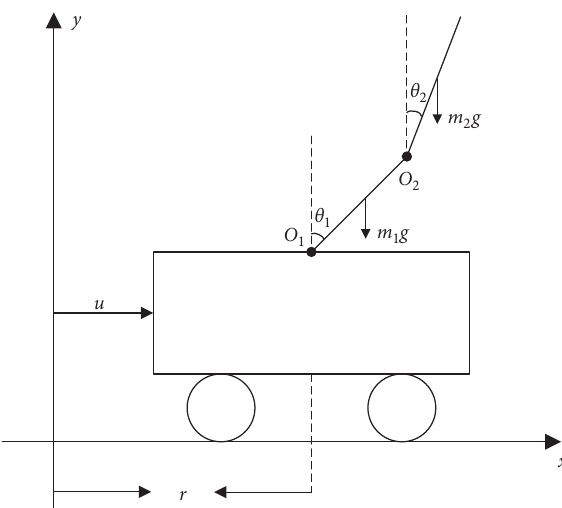
Figure 1: Motion analysis sketch of two-stage inverted